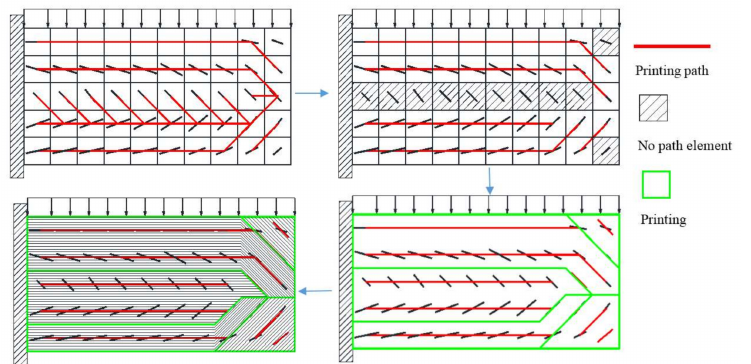
Figure 14. Principle of printing path and section